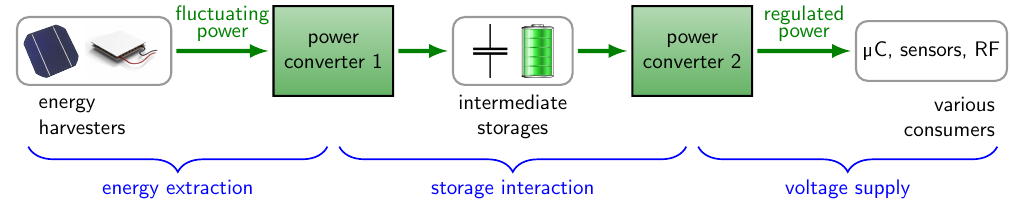
Figure 1. Power converters supply power to consumers from energy-harvesting